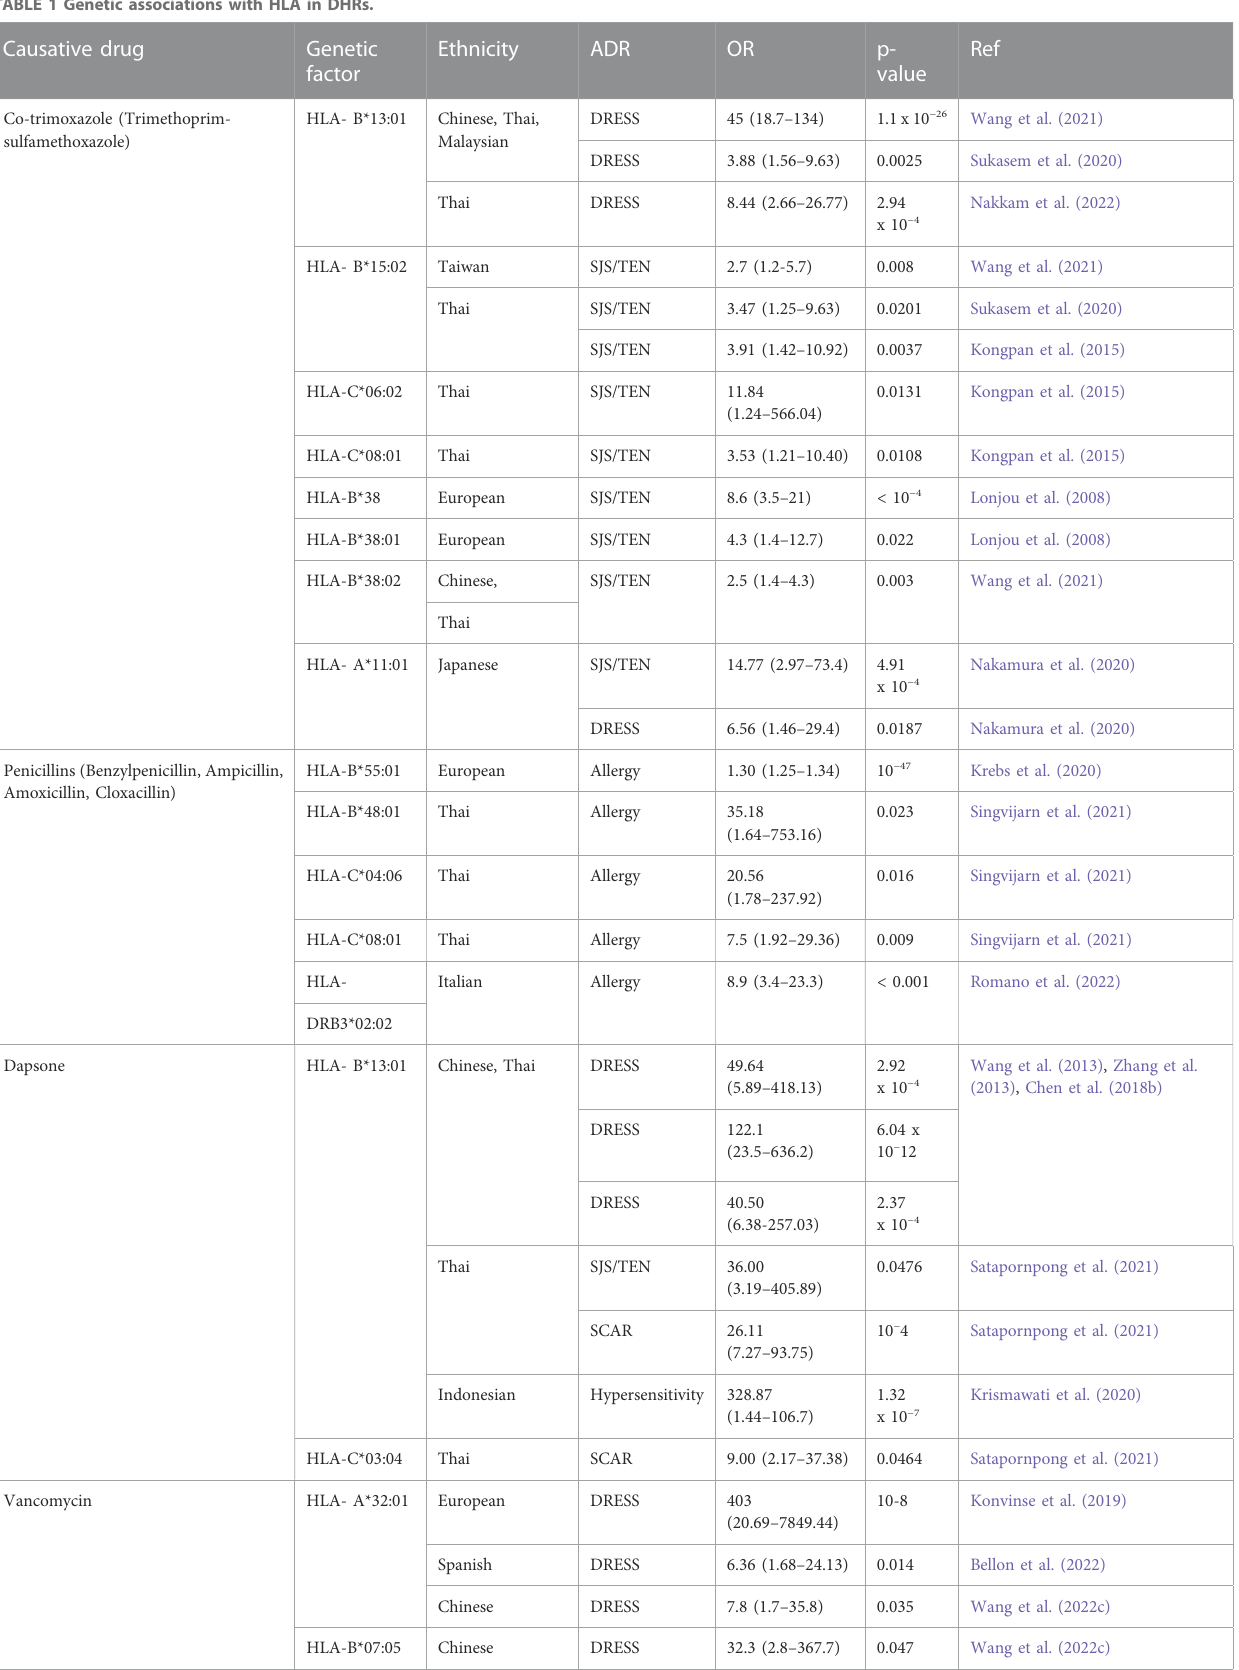
TABLE 1 Genetic associations with HLA in DHRs. Causative